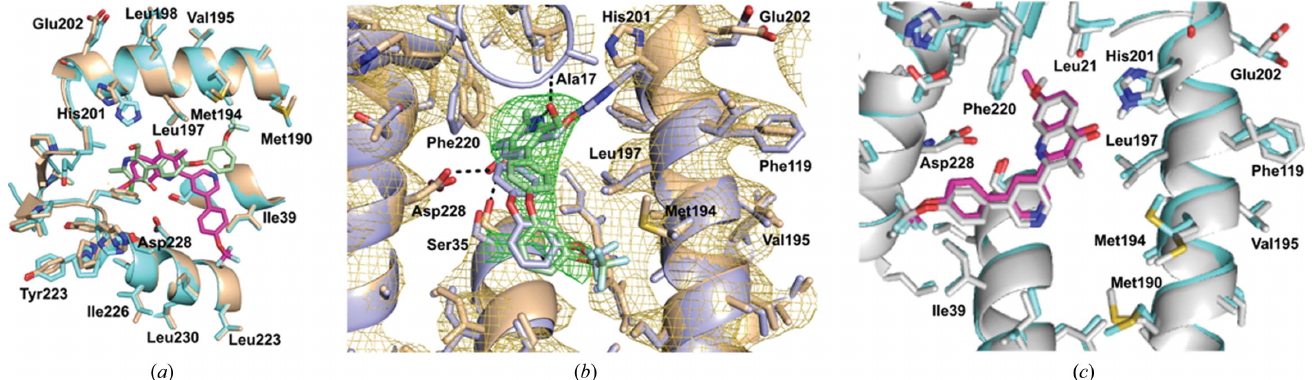
Figure 5 Comparisons of the Q i site. ( a ) The cryo-EM structures of bc 1 –SCR0911 (cyan) and bc 1 –GSK932121 (gold) overlaid. The SCR0911 inhibitor is coloured green and the GSK932121 inhibitor magenta. The overlay of the two structures shows there is no difference in the secondary-structure positions in the two maps and only minor differences in the positions of the amino-acid residues. The largest difference occurs for His201, which forms a hydrogen bond to SCR0911 but not GSK932121. ( b ) An overlay of the Q i site of bc 1 –GSK932121 in the cryo-EM (gold) and X-ray (purple) models. The density in gold corresponds to the EM map, which shows a difference in the position of His201 compared with the X-ray structure. ( c ) An overlay of the Q i site of bc 1 – SCR0911 in the cryo-EM (cyan) and X-ray (grey) models. There are no significant differences between the two models in either side-chain or secondary- structure